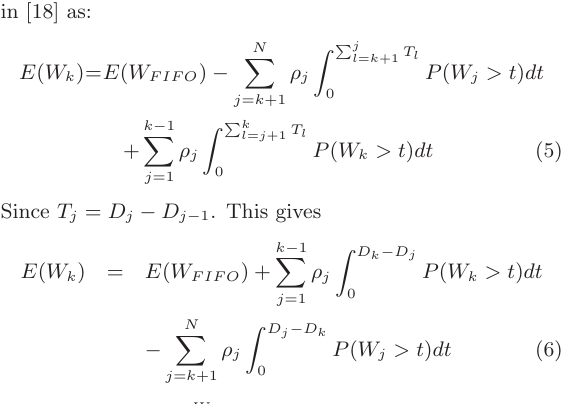
Figure 2: Head-of-line with priority jump [18] in [18]